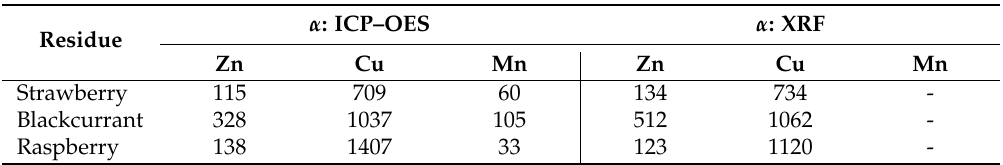
Table 3. Enrichment coefficients for post-extraction residues determined from ICP–OES and XRF.